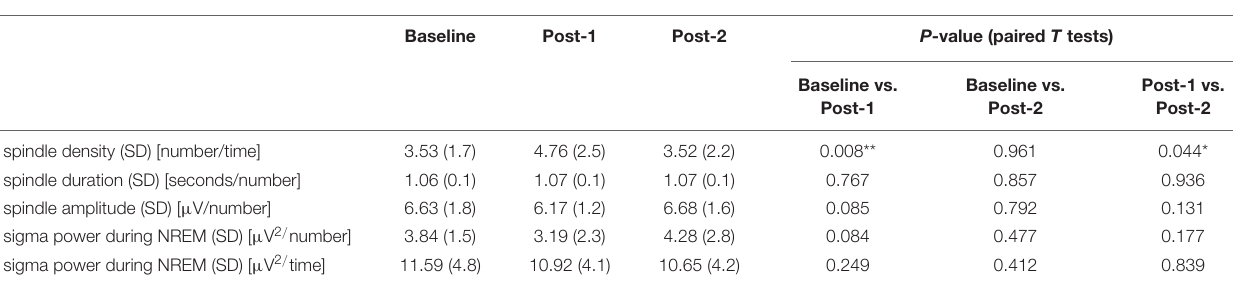
TABLE 3 | Spindle density and morphology at F3.